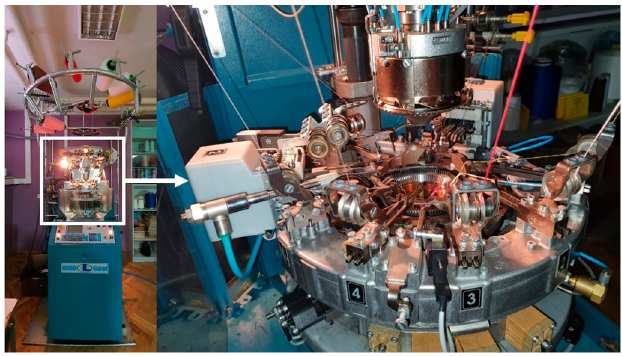
Figure 3. Automatic sock knitting machine, Lonati, Goal FL 626.